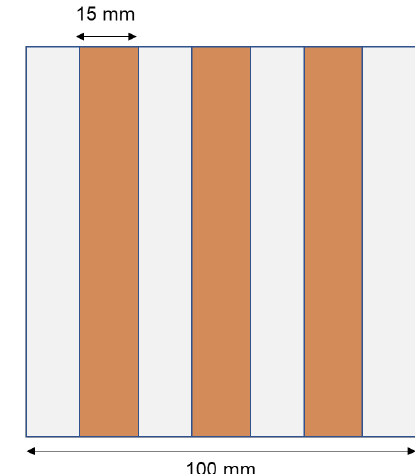
Figure 1. Schematic of the peel testing sample showing the side ( left ) and top view ( right ).